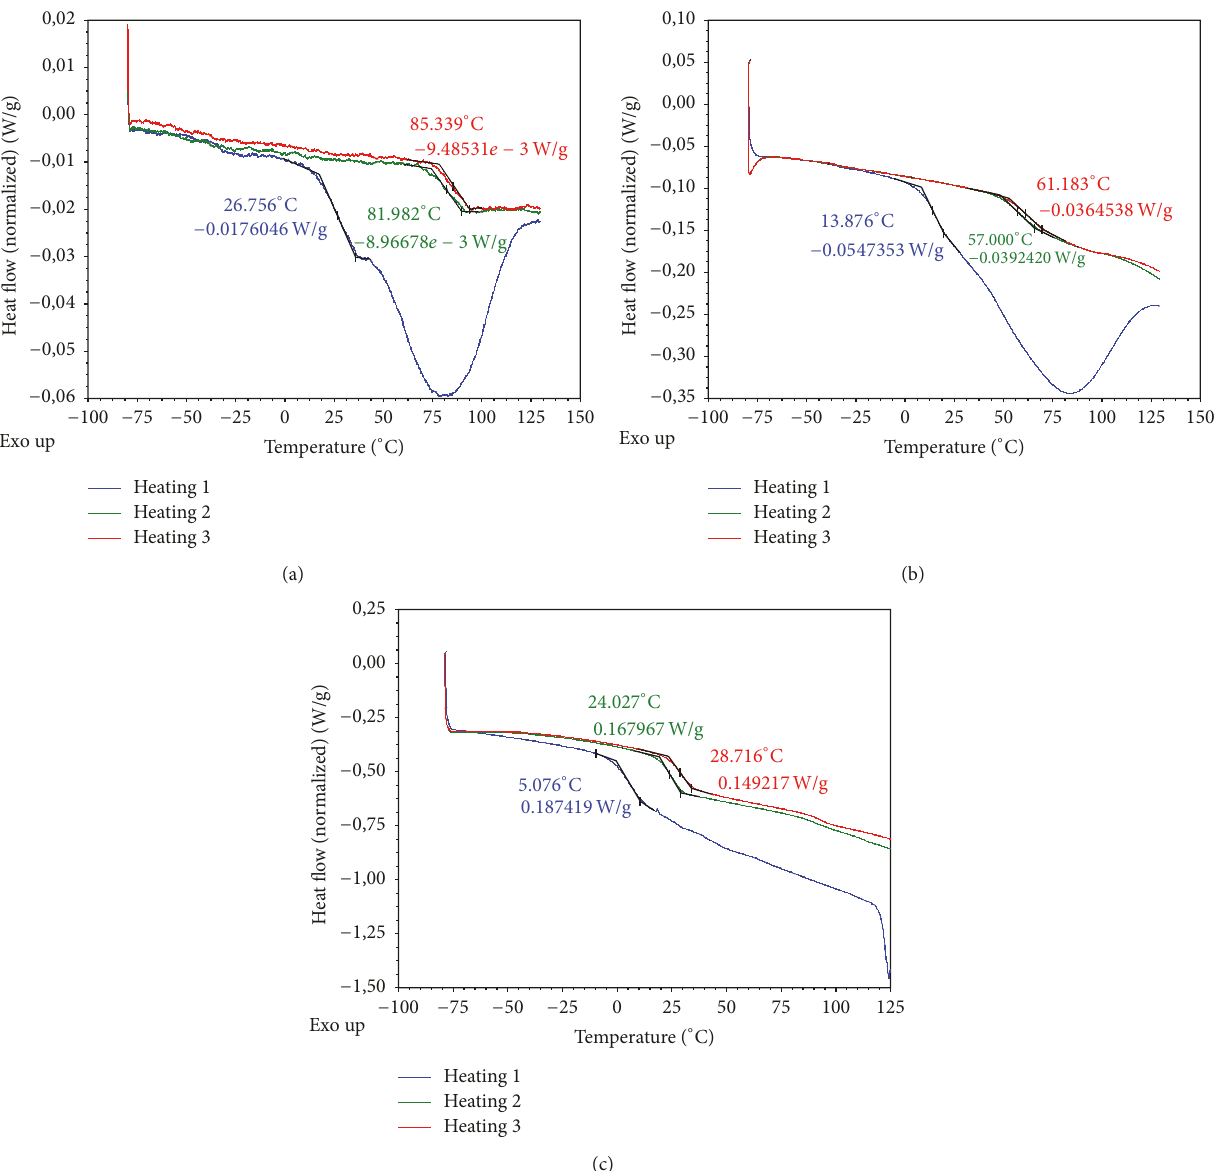
Figure 7: DSC curves of Vivinal GOS using heating rates of (a) 1, (b) 5, and (c) 20 ∘ C/min and three subsequent cycles of heating and